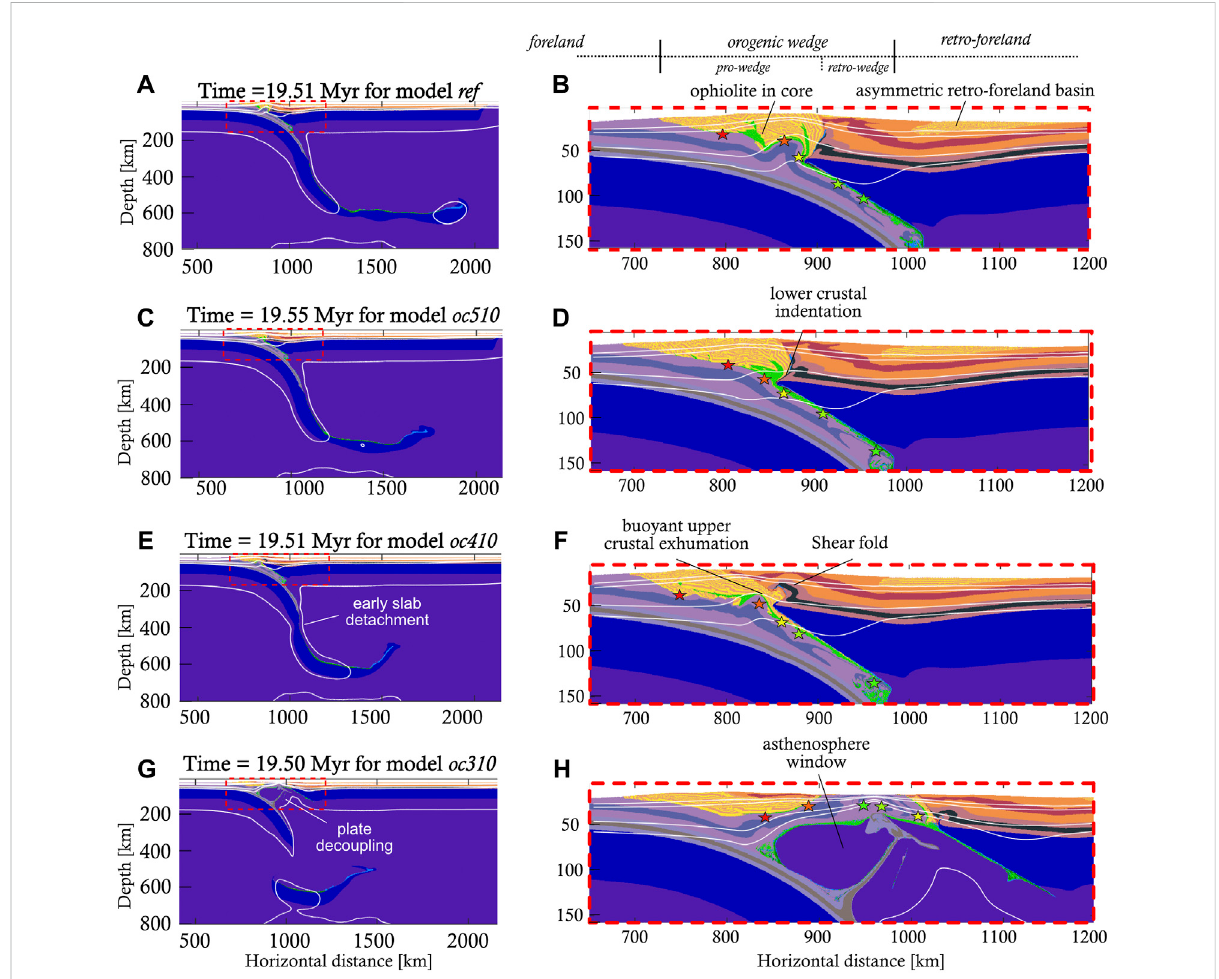
FIGURE 8 Intermediate results of the initial ocean length parameter study (Table 2), showing the differences already present at this stage. Rock composition and isotherms (100 C, 150 C, 350 C, 450 and 1300 C) are displayed and PTt markers are depicted with the usual stars. A 510 km ocean